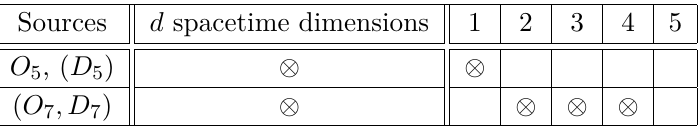
Table 3 . Supersymmetry-preserving source configuration allowing for possible de Sitter solutions in type IIB in d = 5